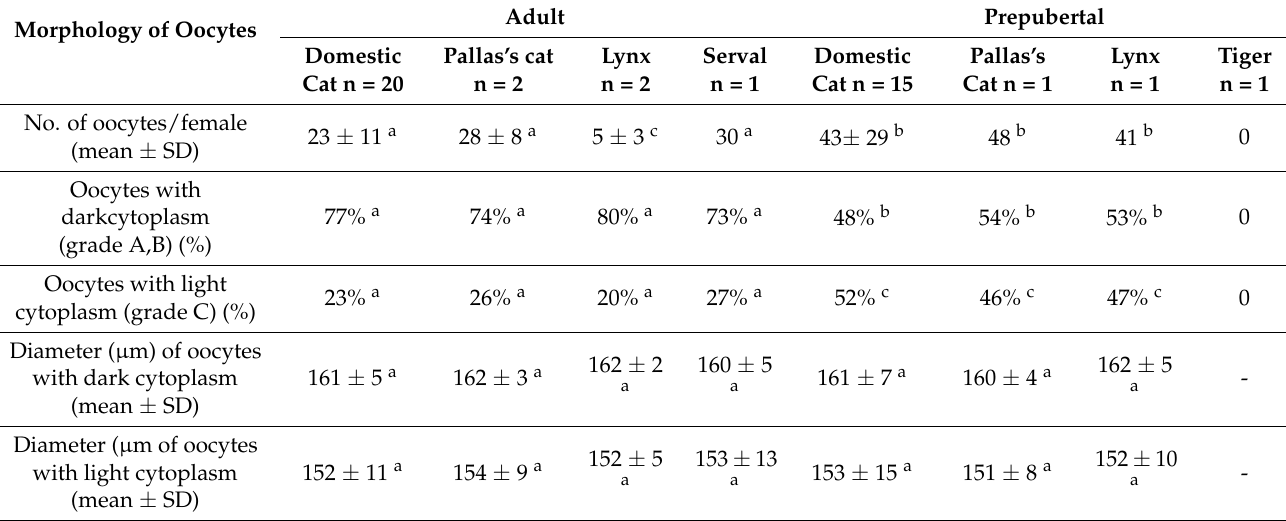
Table 1. Characteristics of oocytes obtained from the domestic and wild cats of different age. Morphology of